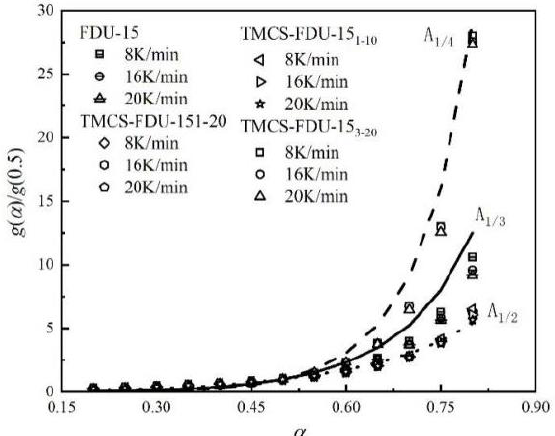
Figure 6. Comparison of standard and experimental master plots of desorption mechanism function for naphthalene on FDU-15.